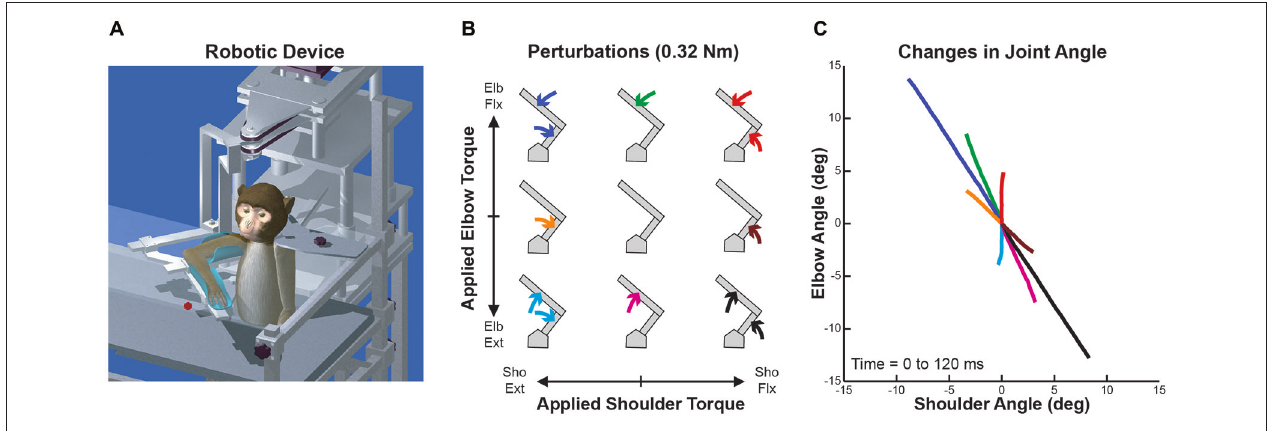
torque negative). Modified from Herter et al. (2009). (C) Joint motion evoked by each perturbation condition. Changes in shoulder and elbow angle in first 120 ms after perturbation onset are represented along the x and y axes, respectively (flexion positive and extension negative). Colors of each line are associated with the respective perturbation conditions in (B) . Modified from Herter et al.